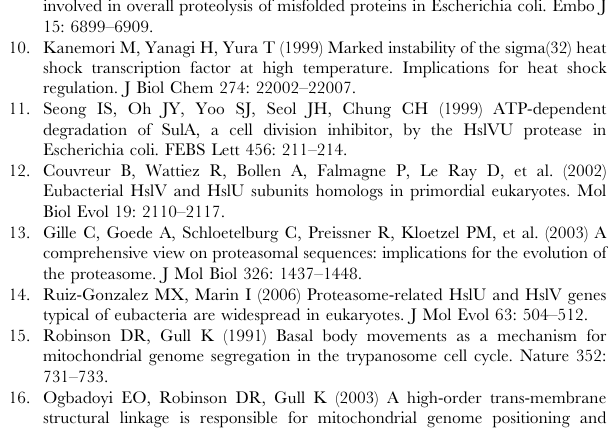
Figure S3 (A). Co-localization of TbHslVU proteins with the kinetoplast. Cells were labeled with anti-HA antibody for TbHslVU-HA (red), YL1/2 antibody for basal body (BB, green), and DAPI for nuclear (N) and kinetoplast (K) DNA. Arrows point to the bright spots of HA labeling, arrowheads point to the basal bodies, and open arrowheads indicate the co-localization of TbHslVU-HA protein with kinetoplasts. Bar: 2 m m. (B). Subcel- lular localization of TbHslV during different stages of kinetoplast cycle. Cells were labeled with anti-HA antibody for TbHslV-HA, and DAPI for nuclear (N) and kinetoplast (K) DNA. Arrows point to the bright spots of HA labeling, and open arrowheads indicate co-localization of TbHslV-HA with kinetoplasts. Bar: 2 m m. Found at: doi:10.1371/journal.ppat.1000048.s003 (4.63 MB TIF) Figure S4 Effects of expressing HA-tagged wild type and mutant TbHslV on cell growth (A) and kinetoplast segregation (B). Cells were labeled with anti-HA antibody (green) and counterstained with DAPI for the nucleus and kinetoplast. The arrows point to the bright spots of HA staining, the solid arrowheads point to the kinetoplasts and the open arrowheads indicate the HA spots superimposed with kinetoplasts. Bar: 2 m m. Found at: doi:10.1371/journal.ppat.1000048.s004 (0.93 MB